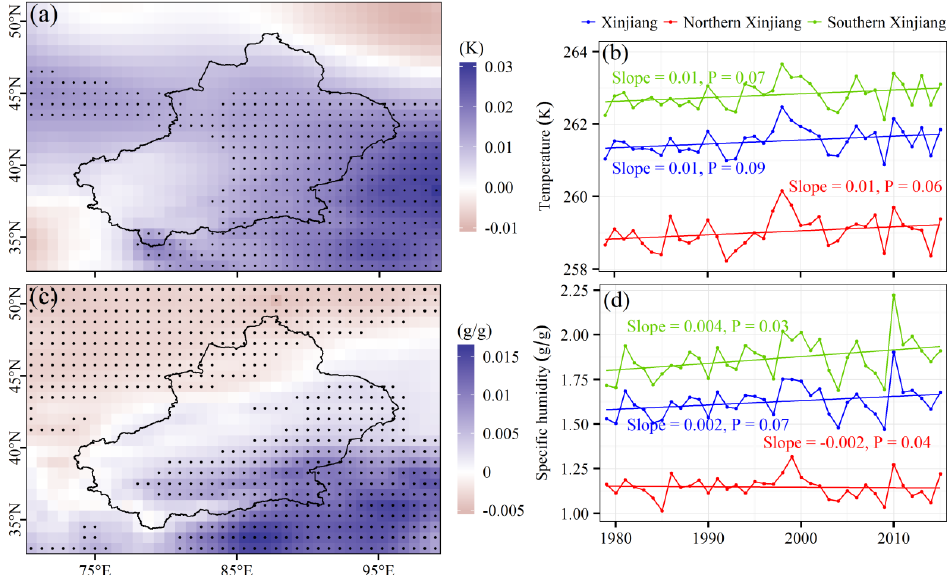
Figure 5. Spatial and temporal trends in lower-tropospheric temperatures and SHs from 1960–2014 over Xinjiang. ( a ) The spatial distribution for trends in temperature. ( b ) Temporal trends in temperature over Xinjiang, northern Xinjiang, and southern Xinjiang. ( c ) The spatial distribution for trends in SH. ( d ) The temporal trends for SH over Xinjiang, northern Xinjiang, and southern Xinjiang. Black dots in the pixels represent significance at the 0.05 level.